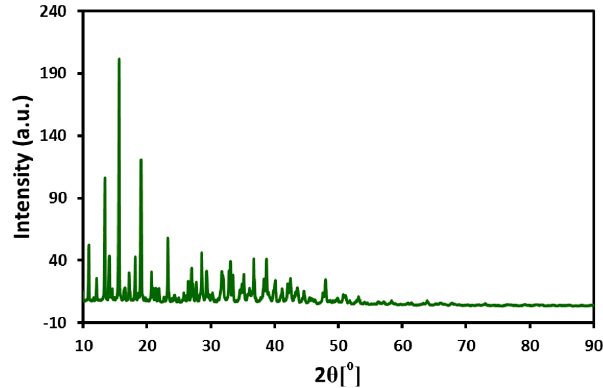
Figure 7. XRD diffractogram of the white colored inorganic residue obtained from the S. persica L . RE.